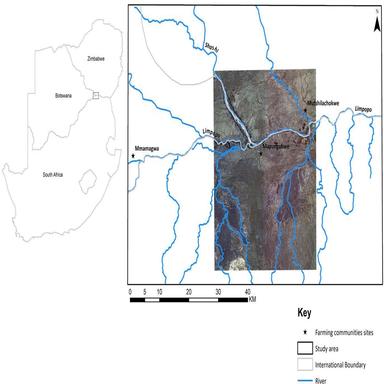
Location of the Shashi-Limpopo confluence area showing sites mentioned in the text and the footprint of the WorldView-2 image used in the study.